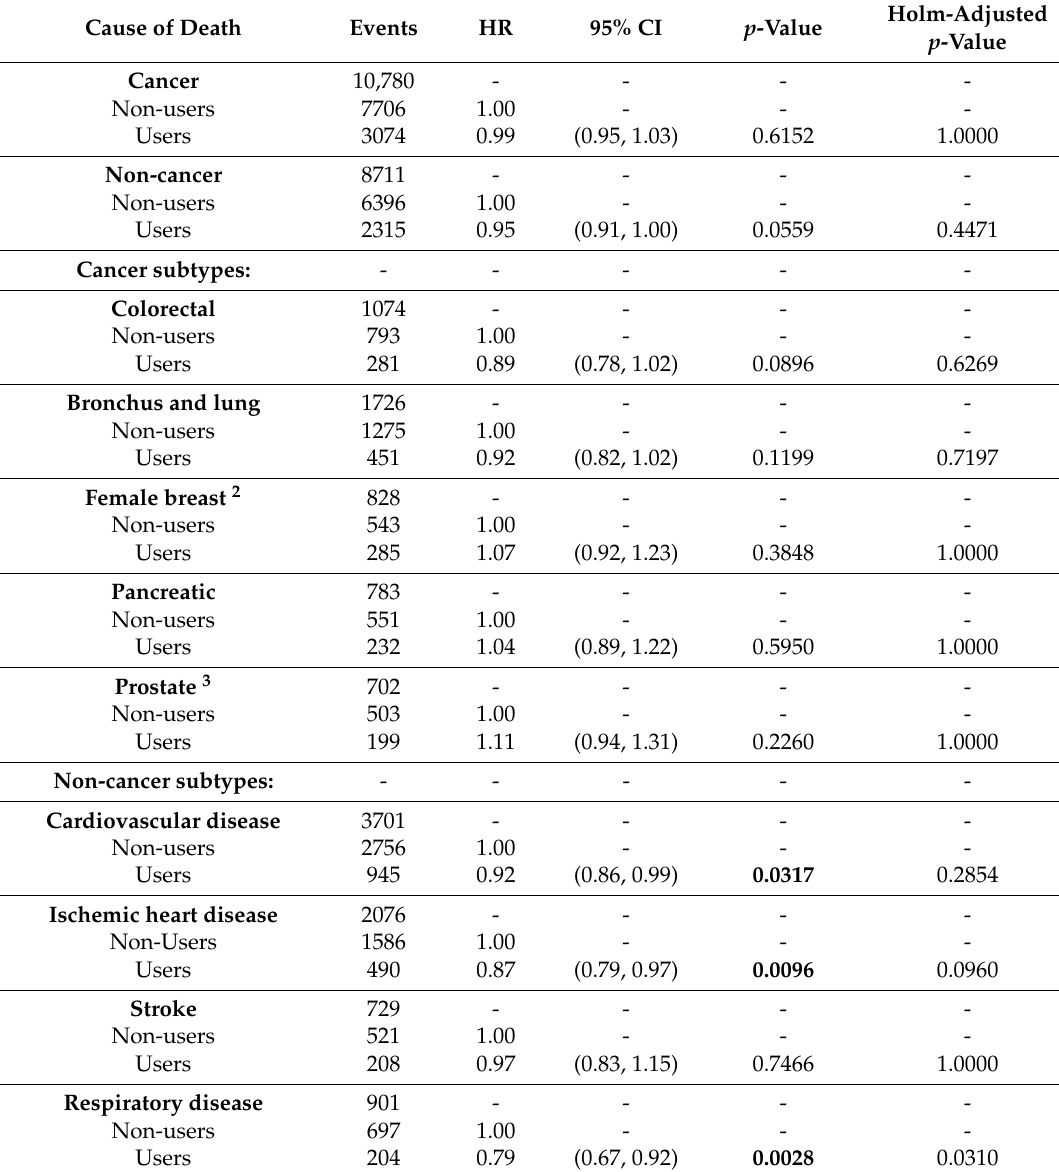
Table 2. Association between regular antioxidants use (independent variable) and cause-specific mortality ( n = 345,626).